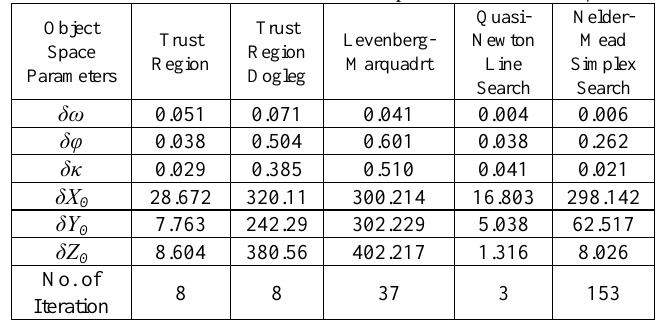
Table 5 Performance of nonlinear least squares methods with φ =